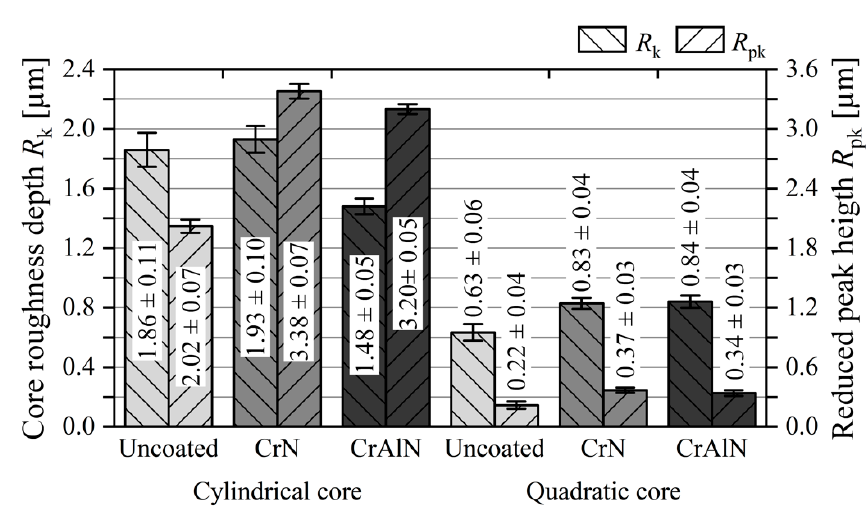
Figure 5. Core roughness depth R k and reduced peak height R pk uncoated as well as as-deposited CrN and CrAlN coated cores.